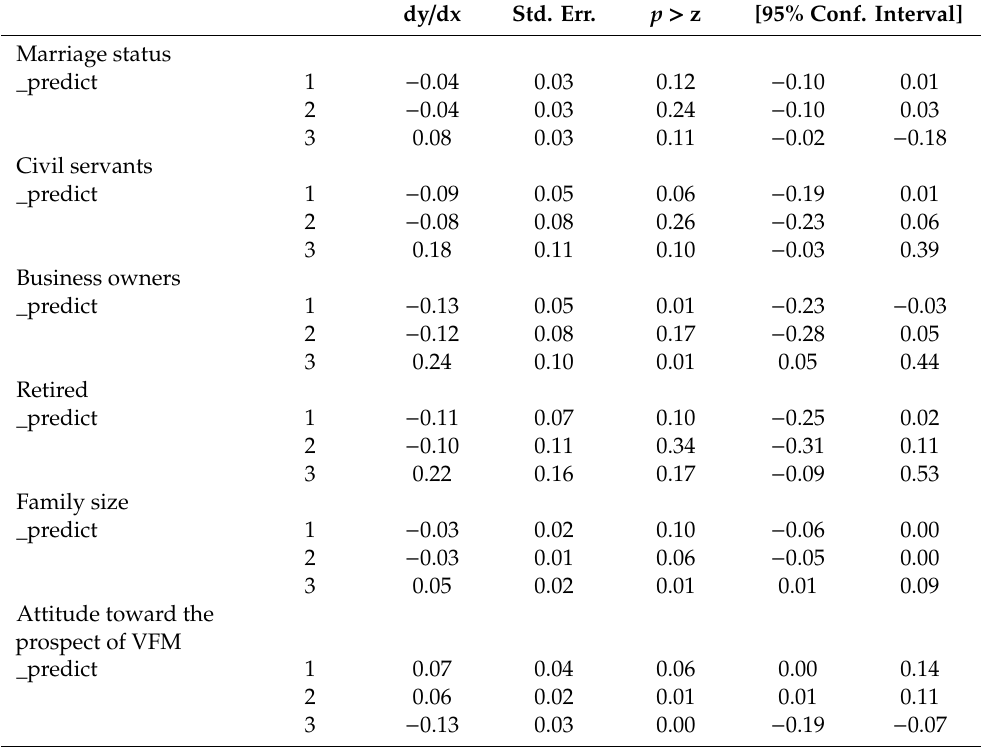
Table 11. Marginal e ff ects of the main a ff ecting factors for urban residents. dy / dx Std. Err. p > z [95% Conf.